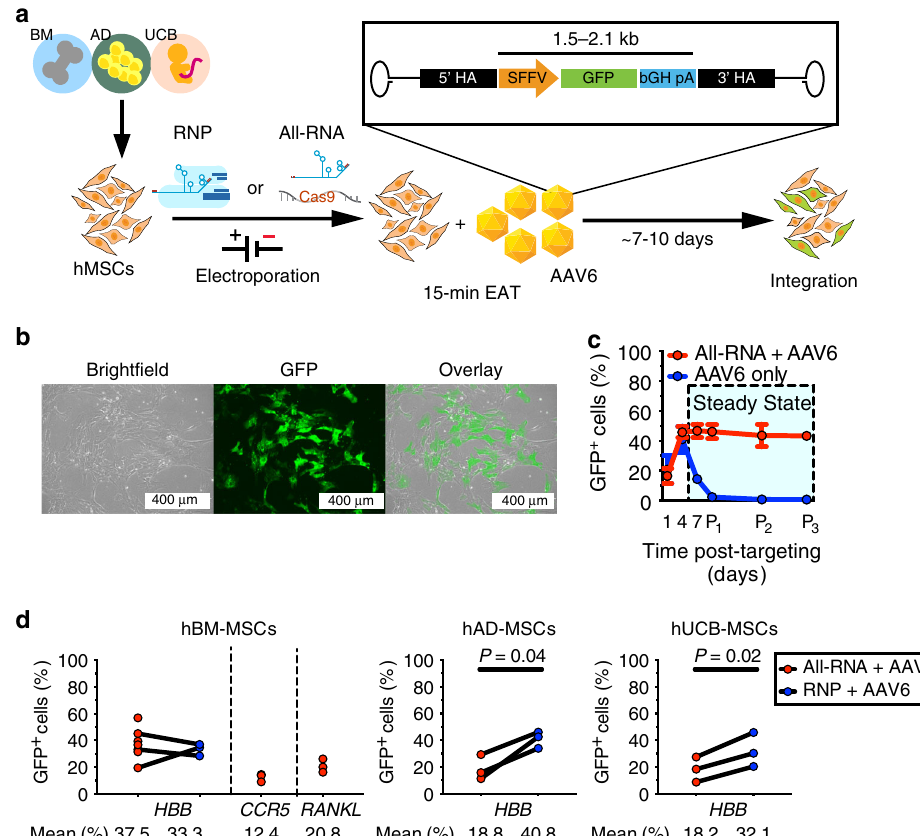
Fig. 1 The Cas9-AAV6 platform is an effective and versatile tool for genome editing in human MSCs. a Schematics outline procedures for genome editing using the Cas9-AAV6 platform in human MSCs derived from the bone marrow (BM), adipose tissue (AD), and umbilical cord blood (UCB) for site- speci fi c transgene integration. MS-modi fi ed guide RNAs and Cas9 nuclease are electroporated as All-RNA cocktail or RNP complex. Then, homologous repair templates containing GFP reporter cassette insert are delivered by electroporation-aided transduction (EAT) of AAV6 vectors for 15 min during recovery period. Integration of GFP-overexpression cassette can be detected ~7 – 10 days later. HA: homology arm b Representative single-channel and overlay images of a GFP + hBM-MSC colony originated from low-density seeding (220 cells/cm 2 ) one passage in culture after nuclease electroporation and EAT. Scale bars represent a distance of 400 µ m. GFP + colony formation is observed in targeting from all 12 biological hMSC donors described in this study. c Dots and lines represent average frequencies of GFP + cells in hBM-MSCs (biological replicates: n = 6) at different timepoints after HBB locus